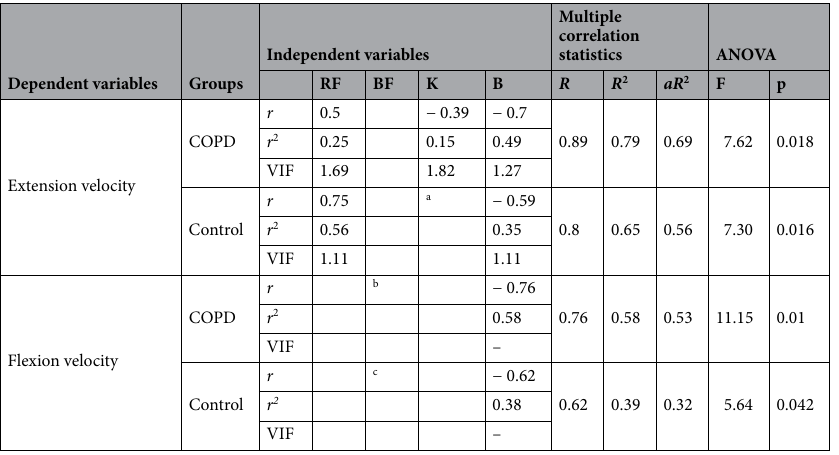
Table 3. Backward stepwise regression analysis to quantify the relationships between movement velocity and active and passive parameters. Numerical data indicate the statistical parameters of the best model obtained by the backward stepwise regression. The model preceding the best model is indicated in the table by lowercase letters and the statistical parameters are the following: RF: Rectus Femoris; BF: Biceps Femoris; K: stiffness; B: viscosity; R: coefficient of correlation; R 2 : coefficient of determination; aR 2 : adjusted R 2 ; r : partial coefficient of correlation; r 2 : partial coefficient of determination; VIF: Variance Inflation Factor; F: critical value for statistical significance; p: probability value for statistical significance. a R = 0.8; F = 4,301; p = 0.051; b R = 0.81; F = 3.986 p = 0.071; c R = 0.75; F = 3.114; p =